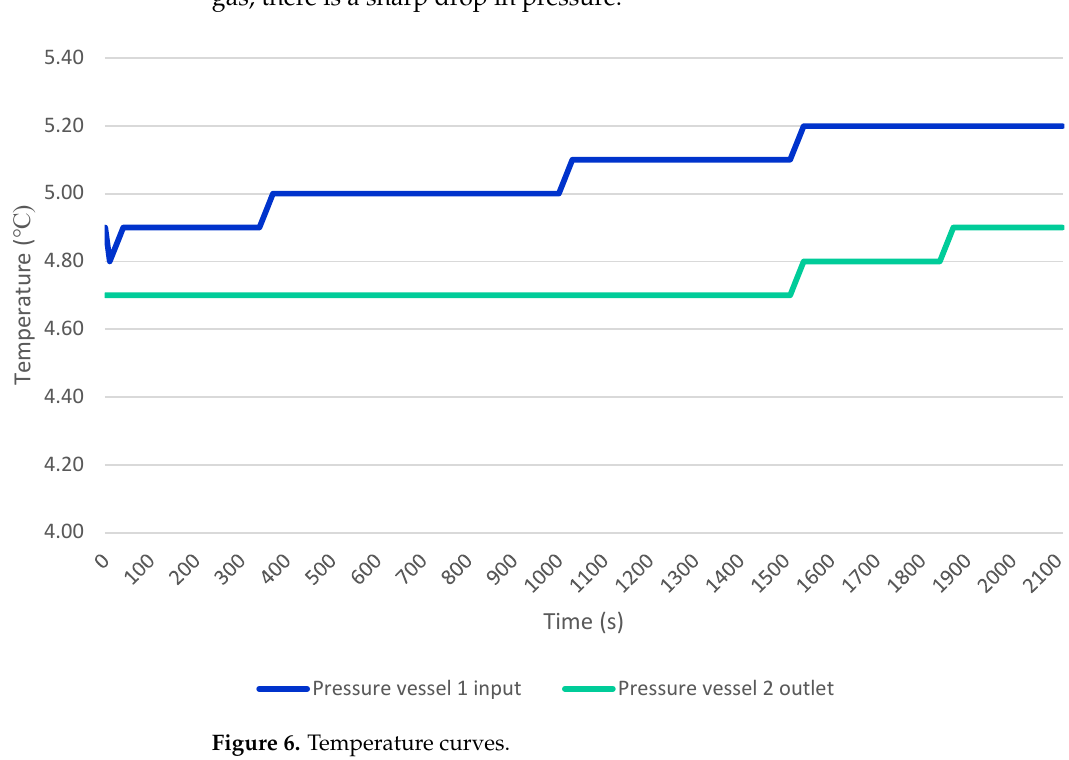
Figure 5. Pressure curves.